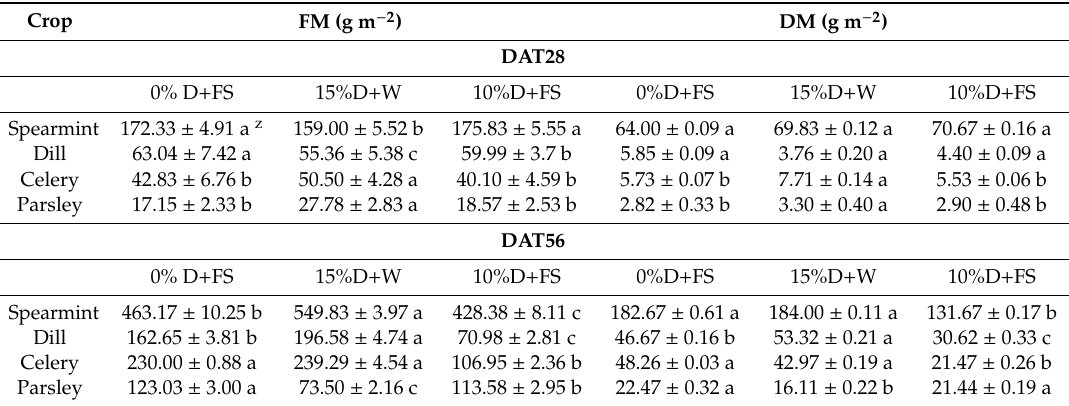
Table 5. Mean (and standard deviation) fresh and dry matter in g m − 2 of secondary crops 28 and 56 days after transplanting (DAT) during the 2nd Period.